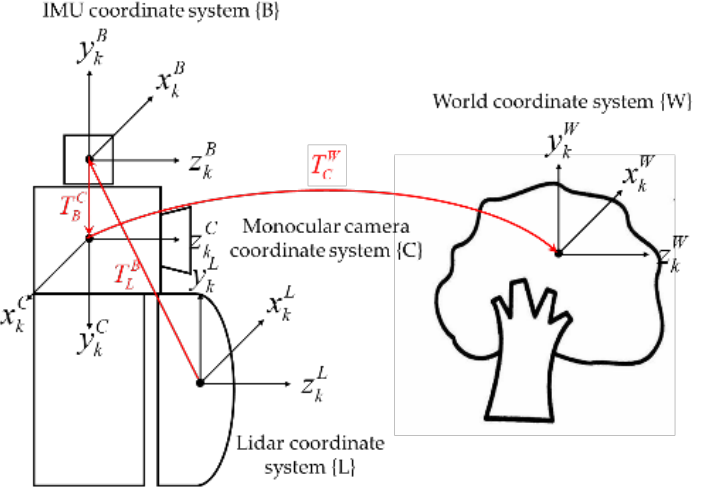
Figure 1. Point cloud real-time reconstruction system with a single-line lidar based on visual–IMU fusion.